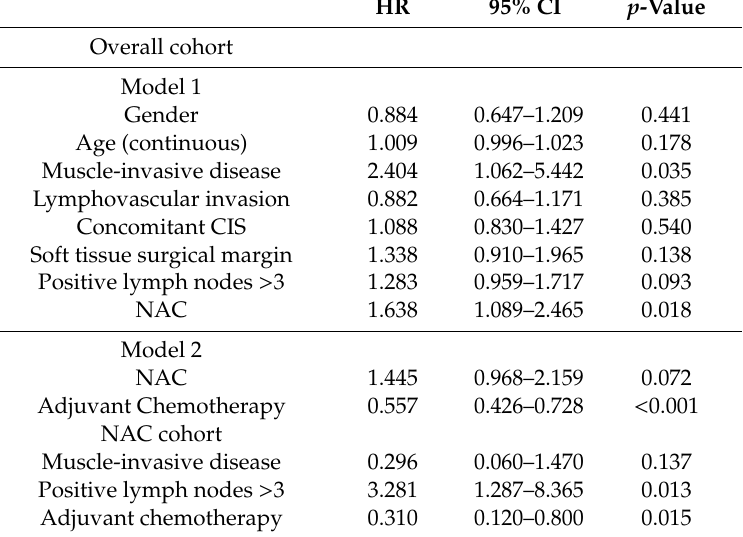
Table 3. Multivariable Cox regression analyses for predictors of overall survival (OS) in the overall cohort and in the neoadjuvant chemotherapy (NAC)